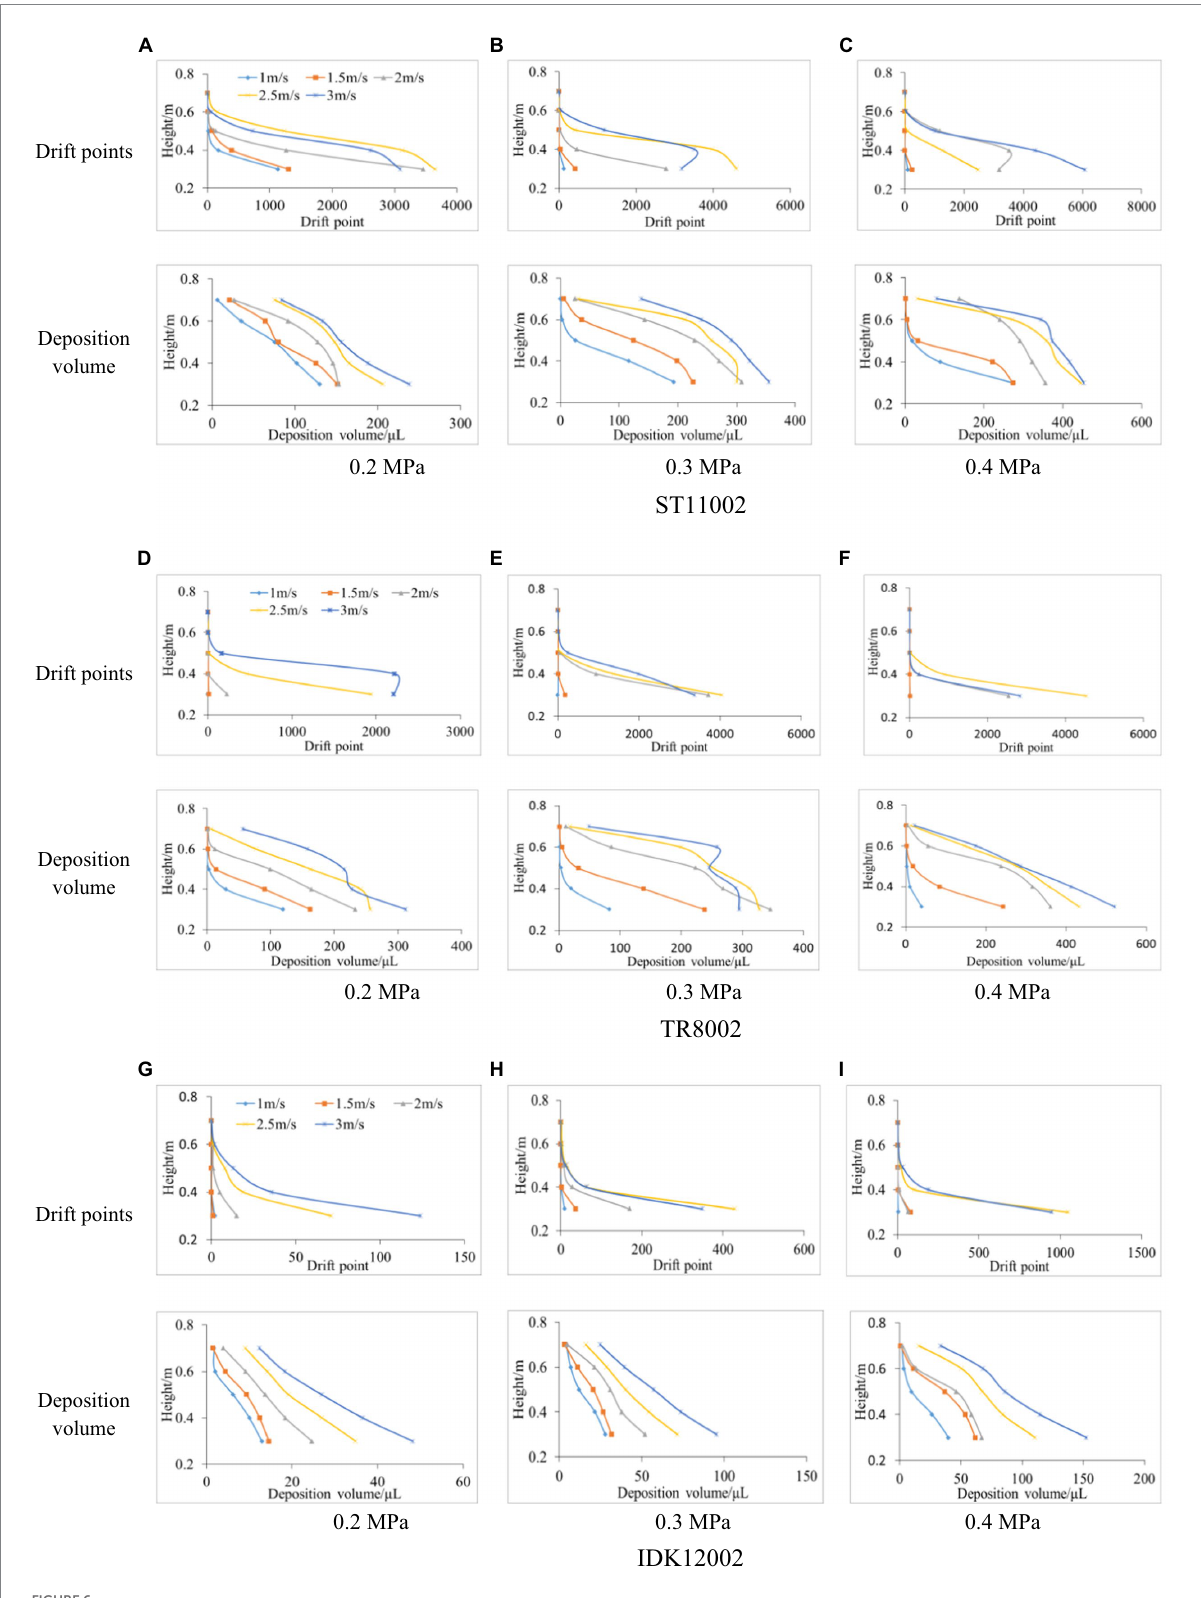
FIGURE 6 Spray drift obtained with passive collectors and LiDAR sensors at various heights for the three nozzles. (A) 0.2 MPa. (B) 0.3 MPa. (C) 0.4 MPa. (D) 0.2 MPa. (E) 0.3 MPa. (F) 0.4 MPa. (G) 0.2 MPa. (H) 0.3 MPa. (I) 0.4